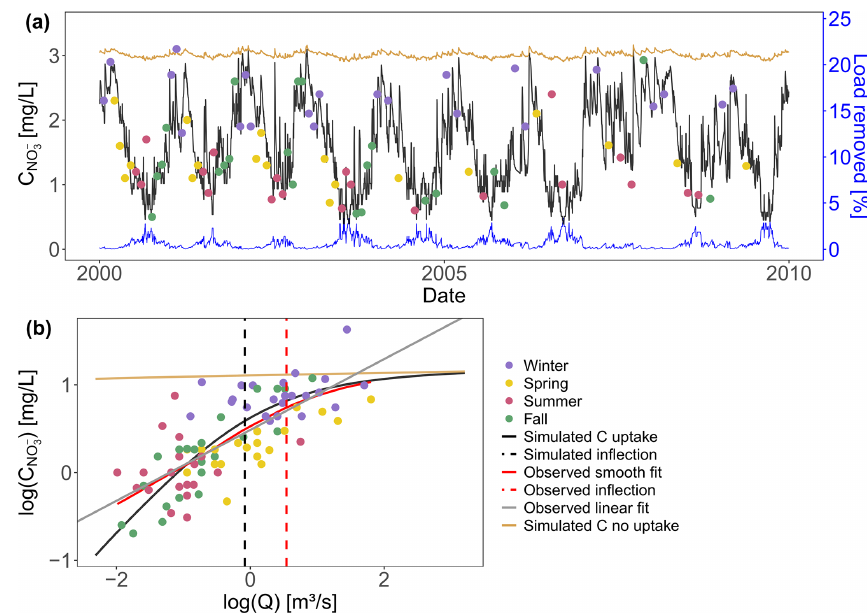
Figure 2. (a) Simulated and observed NO 3 − concentrations at the Selke Meisdorf gauging station for a 10-year simulation period (2000– 2010; NSE = 0 . 50). One data point ( C ∼ 5mgL − 1 ) is not shown here. The simulated median percentage of load removed in the stream network (blue line) is given during the same time period as well as the simulated C with no uptake ( v f = 0). (b) The observed NO 3 − concentrations and Q are log-transformed and plotted together with the simulated C – Q data for 2000–2010. A smoothed spline is fitted to the observed and simulated C – Q data (described as observed smooth fit and simulated C , respectively, in the legend), and Curv max values of − 0 . 35 and − 0 . 28 are calculated at the respective discharges of 1.72 and 0.92m 3 s − 1 , indicating the smoothed spline inflection points.